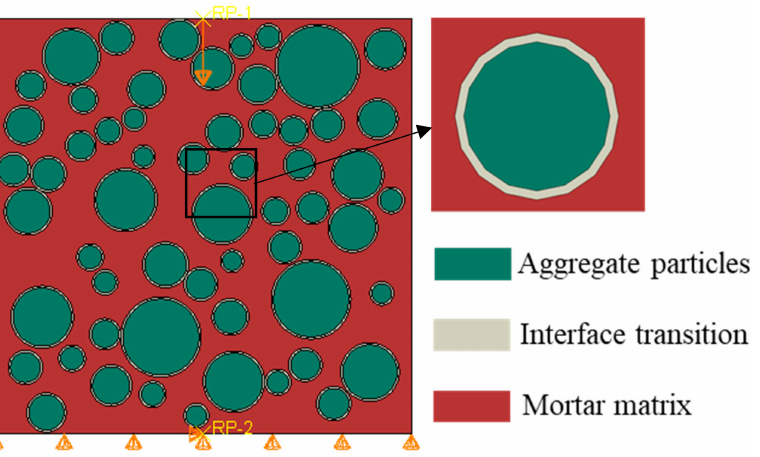
Figure 5. Two-dimensional mesonumerical